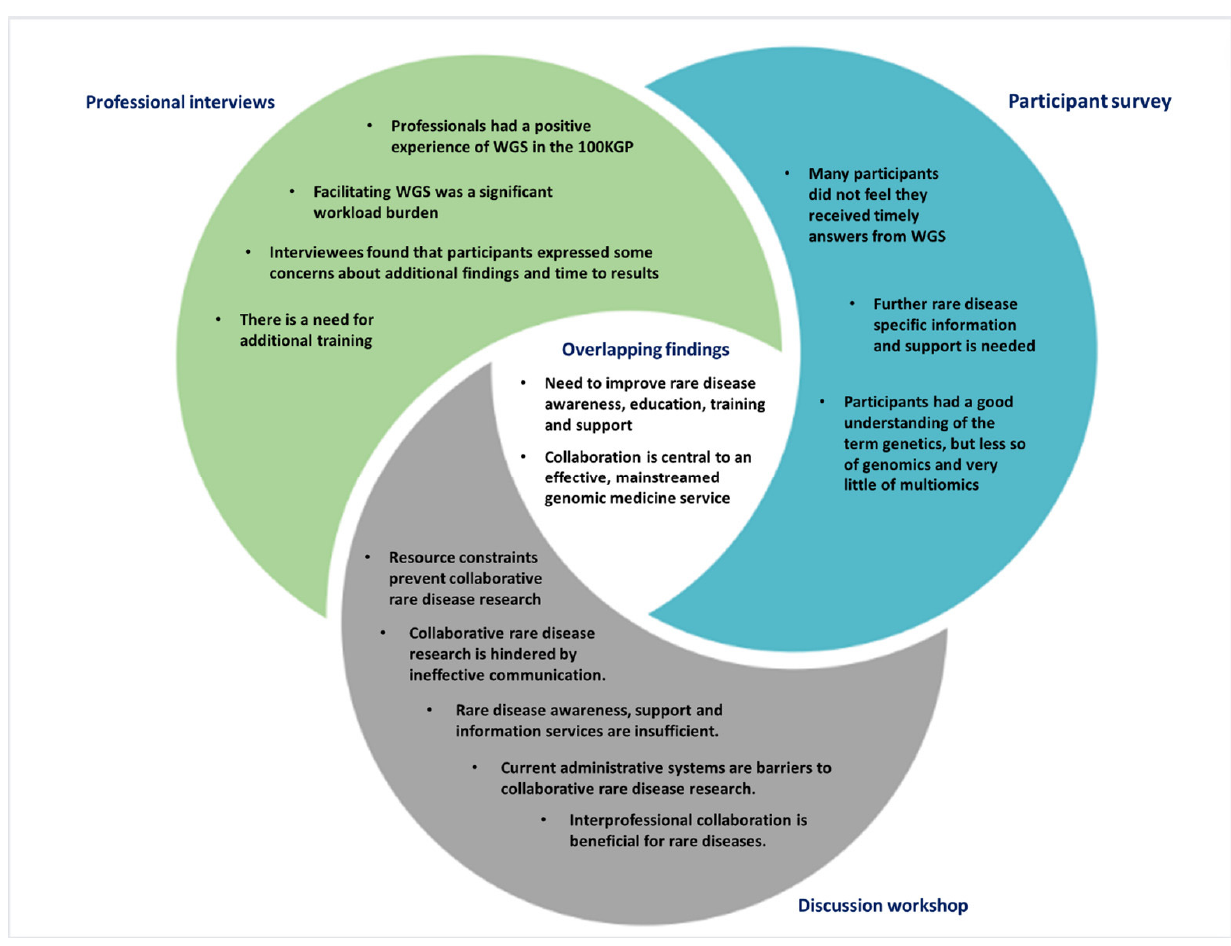
Figure 6. Summary of central themes identified from survey, interviews, and workshop.